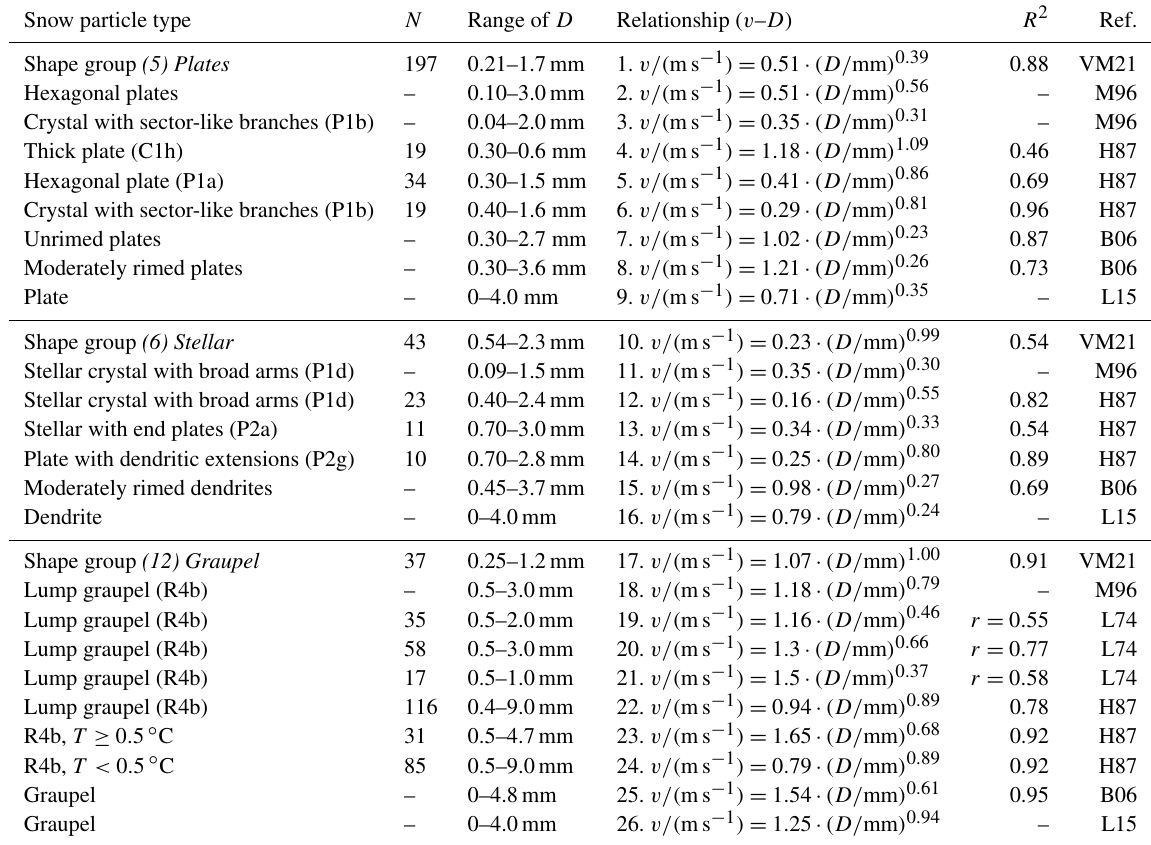
Table 6. The v vs. D relationships of previous studies given by Locatelli and Hobbs (1974) L74, Heymsfield and Kajikawa (1987) H87, Mitchell (1996) M96, Barthazy and Schefold (2006) B06, and Lee et al. (2015) L15 are shown for some shapes that were selected for the comparison and correspond to (5) Plates , (6) Stellar , and (12) Graupel . The power laws for M96 have been determined by using Eqs. (20) and (22) in Mitchell (1996). The relationships found in this work are also shown as VM21. The power laws from the literature have been converted to use the same units, i.e., mm and ms − 1 , as in VM21. The snow particle type, the total number of particles N , ranges of particle sizes D , v vs. D relationships, the correlation coefficient R 2 , and the references of the studies are displayed. In some of these studies, the particle size is defined somewhat differently. However, in H87 and M96, D is defined as D max as in VM21. Magono and Lee (1966)’s symbols are sometimes added for shape clarification. These v vs. D relationships are shown in Fig. 13. To easily connect the fit lines to the power laws, the same relationship numbers have been used in Table 6 and Fig.